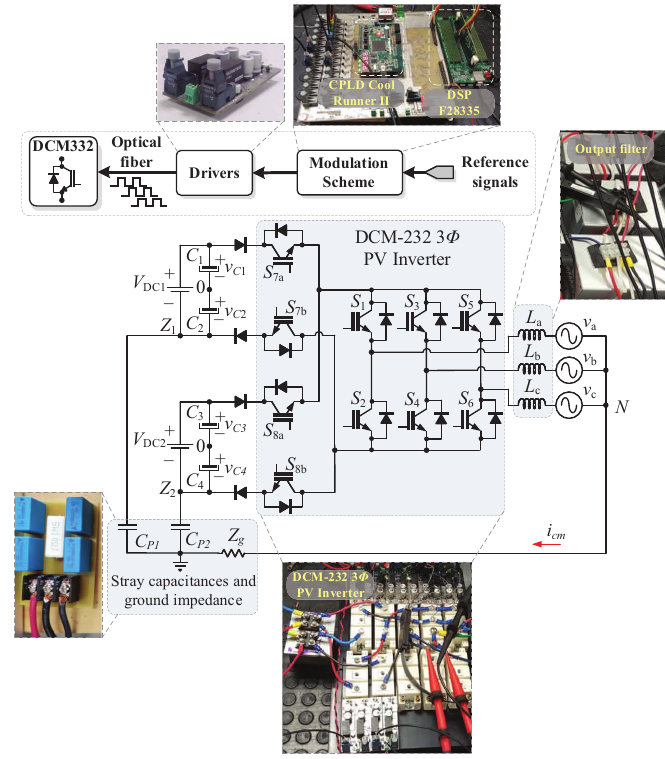
Figure 11. Experimental setup of the DCM-232